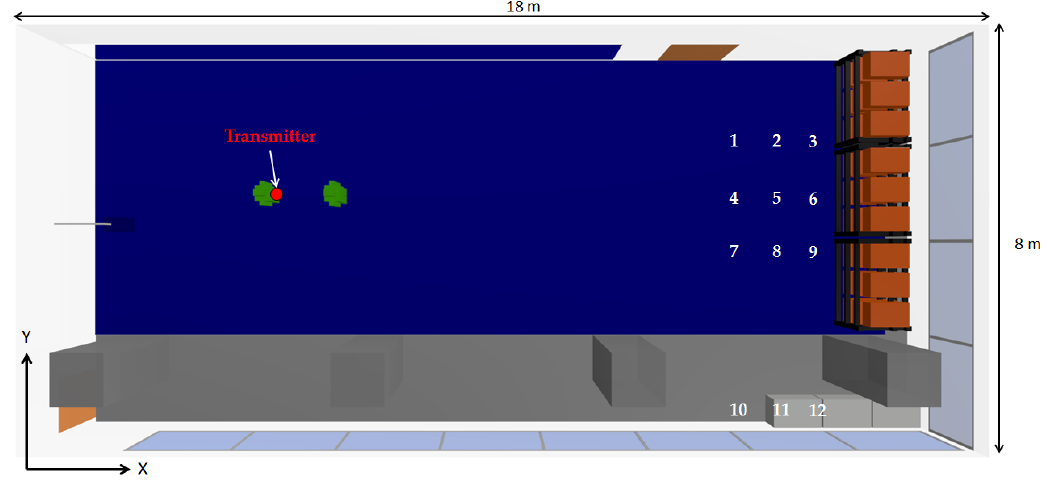
Figure 8. Upper view of the scenario with the new measurement configuration. The white numbers represent the measurement points.